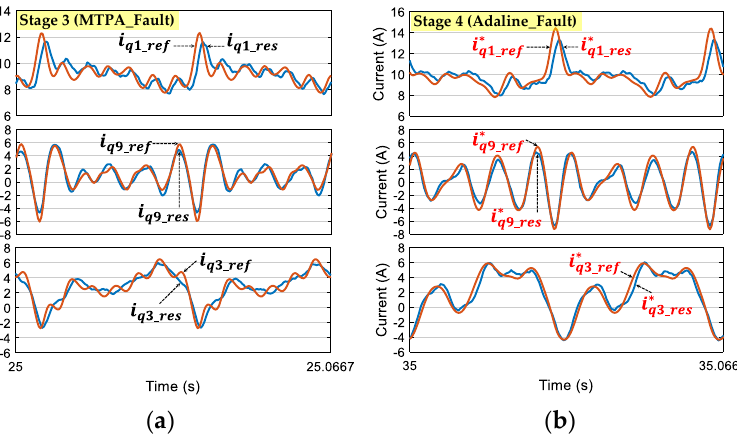
Figure 10. (Experimental result) Switch from stage 3 to 4 when phase A is opened at 300 rpm: ( a ) elimination of T error with the proposed Adaline-based scheme ( η = 0.01) in stage 4; and ( b ) torques of fictitious machines ( T FM 1 , T FM 2 , T FM 3 ) in one electrical period.